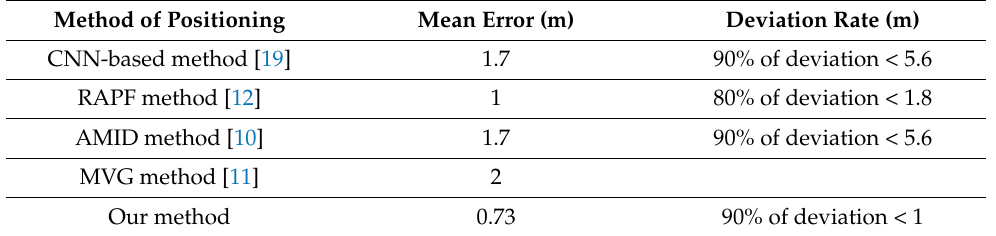
Table 4. Accuracy comparison of different magnetic-based positioning